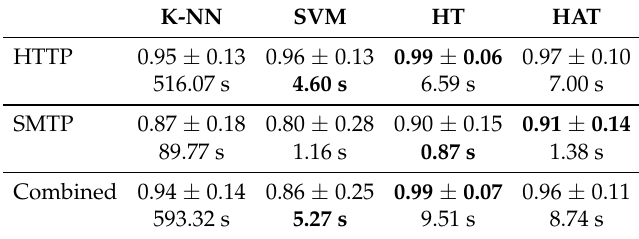
Table 1. Stand-alone model results. Bolded values are the best results between the four different model